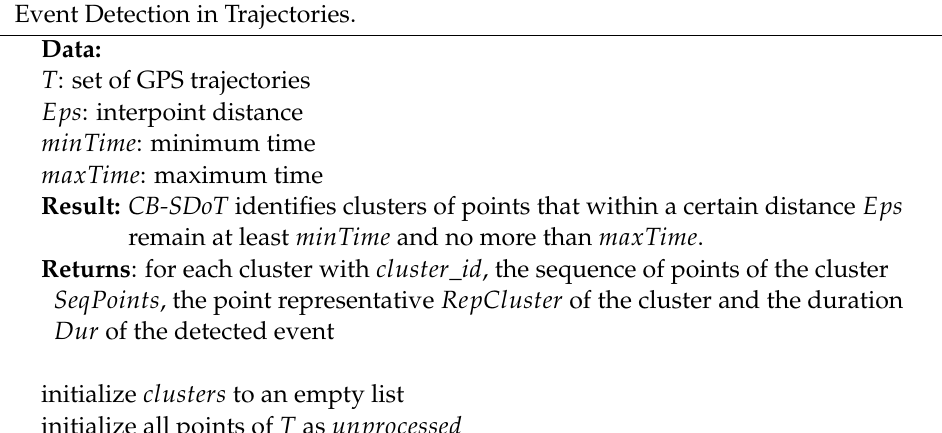
Algorithm A1: The CB-SDoT algorithm: Clustering-based Stop and Deceleration Event Detection in